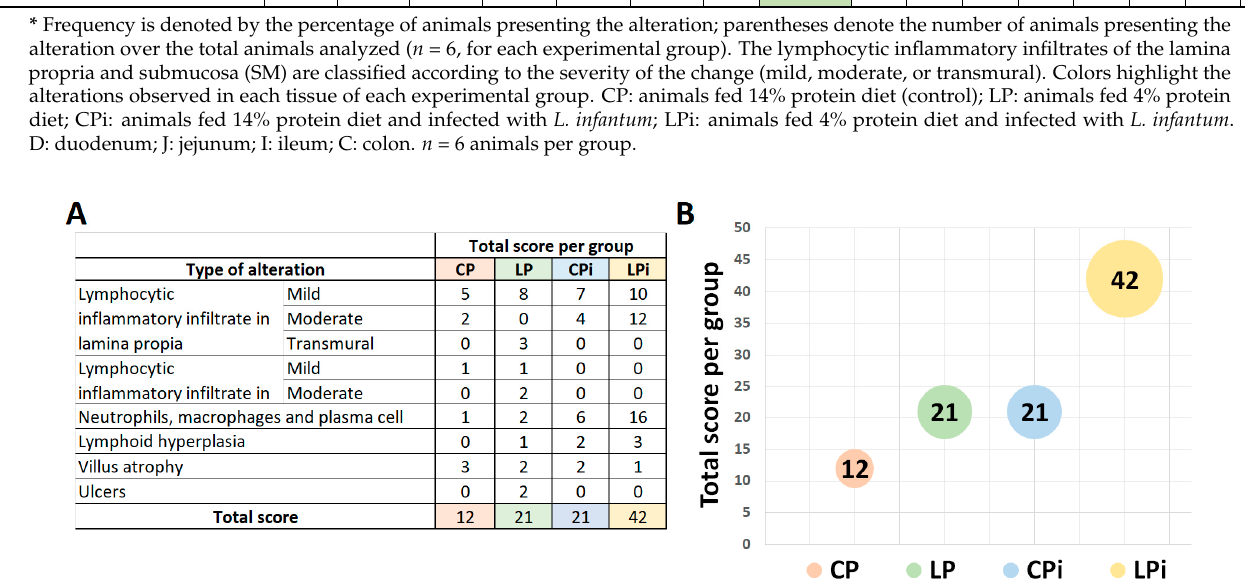
Figure 4. Total score of histopathological changes observed in the intestine regions of malnourished BALB/c mice infected with L. infantum . ( A ) The score values represent the sum of the changes observed in each experimental group according to the presence or absence of the alteration and its degree of severity (Table S2). ( B ) Total score of immunological and structural changes observed in each experimental group. n = 6 animals per group. CP: animals fed 14% protein diet, LP: animals fed 4% protein diet, CPi: animals fed 14% protein diet and infected, LPi: animals fed 4% protein diet and infected.